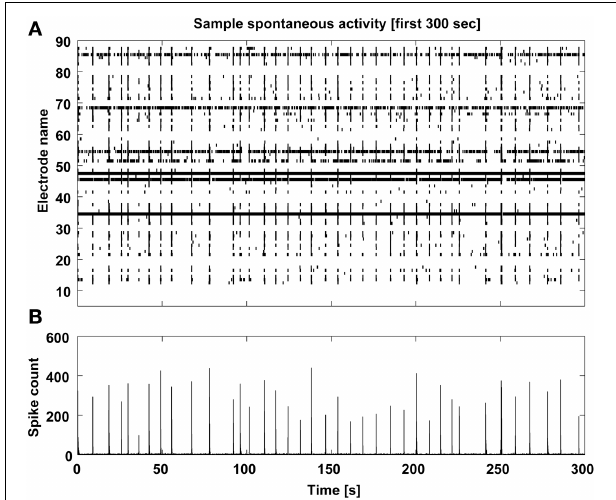
FIGURE 8 | Sample spontaneous activity display. The multiunit spontaneous activity is displayed as raster-plot (A) across the detecting microelectrodes for the first 5min of each data file, and its corresponding spike count is computed (B) to reveal the MEA-wise stereotypical episodic synchronization of neuronal activity.